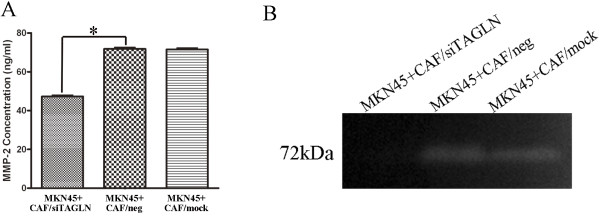
TAGLN enhances tumor metastasis by upregulated MMP-2. A: MMP-2 expression in CAF decresed obviously after TAGLN RNAi by ELISA. *, P < 0.05 by one-way analysis of variance (ANOVA). Error bars depict the standard error around the mean. B: knockdown TAGLN impaired the ability of CAF to secret MMP-2 by gelatin zymography.